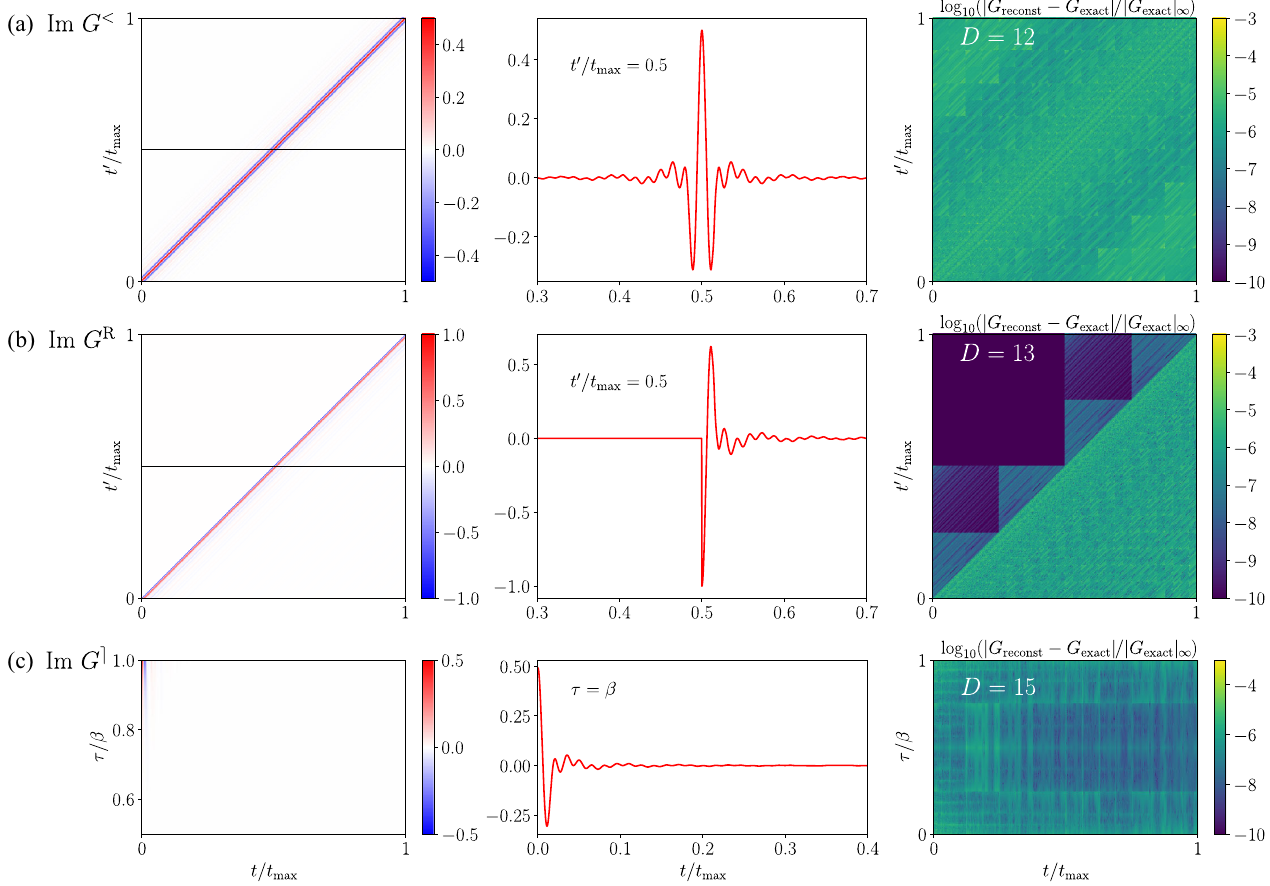
FIG. 19. Real-time and mixed Green ’ s functions computed for the equilibrium paramagnetic system. Exact data for the imaginary parts of (a) the lesser, (b) the retarded, and (c) the left-mixing component are shown in the left panels. Cuts through these functions at 1 = 2 or τ = β ¼ 1 (horizontal lines in the left panels) are shown in the middle panel. The right panels show the logarithm of the t 0 =t max ¼ error for cutoff ϵ ¼ 10 − 10 together with the bond dimension D automatically set by ϵ . The symbol j (cid:2) (cid:2) (cid:2) j ∞ denotes the maximum norm of a tensor, which is the maximum of the absolute values of its